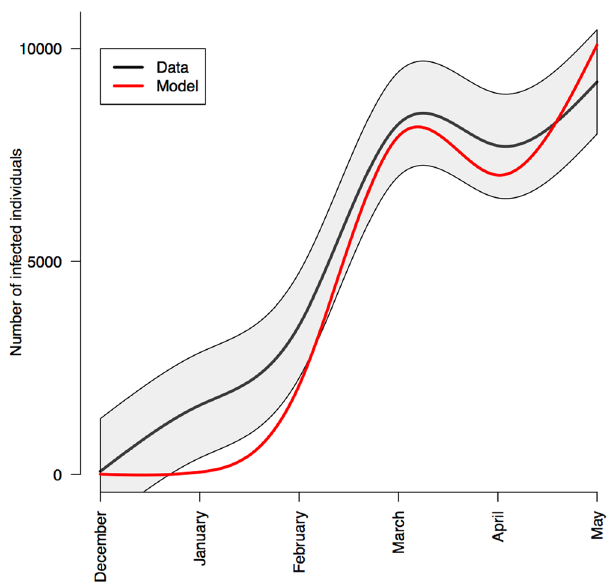
Figure 3. Match between estimated monthly epidemiological data (black, shaded grey area shows the confidence interval based on a Gaussian distribution) and the most parsimonious mathematical model including mosquito abundance and expressed need for protection on Twitter (red line). Estimated transmission parameters are x 0 = 3.76 10–4, x 1 = 0.295, x 2 = 0.644 and τ = − 1. See Table 1 for model selection